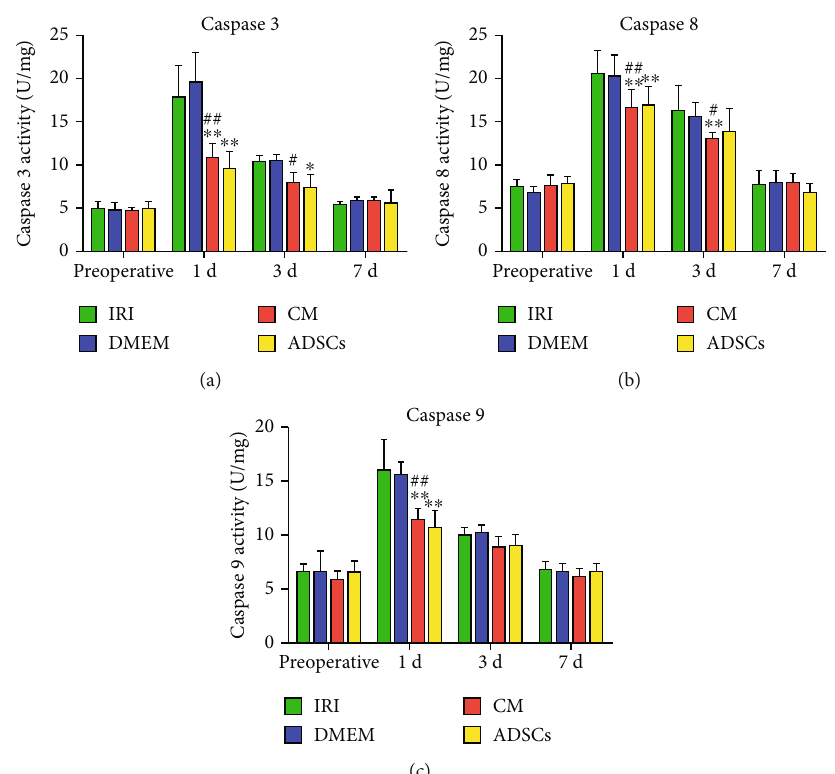
Figure 3: Caspase activity levels: (a) caspase 3, (b) caspase 8, and (c) caspase 9. ∗ P < 0 : 05 and ∗∗ P < 0 : 01 compared to IRI group; # P < 0 : 05 and ## P < 0 : 01 compared to DMEM